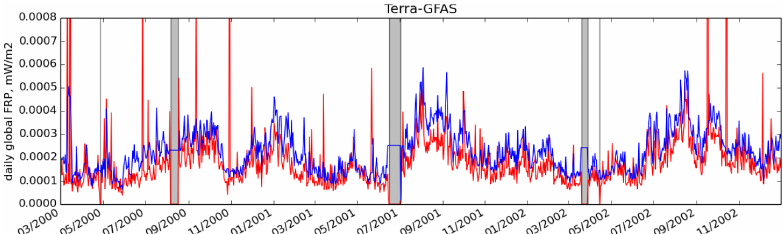
Figure 11. Daily global FRP from Terra-GFAS from 24/02/2000 to 31/12/2002 using non-corrected observations (red) and corrected ob- servations (blue). The grey areas indicate that the MODIS/Terra observations were not available and that persistence was used instead in